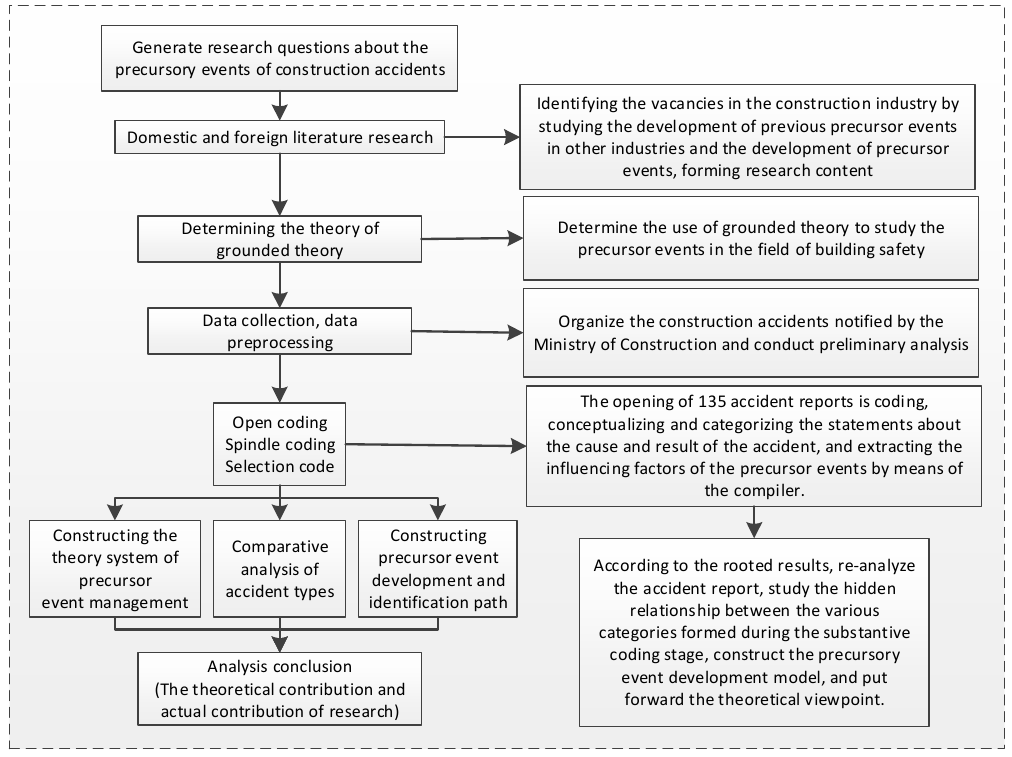
Figure 1. The procedure of using grounded theory in this study.